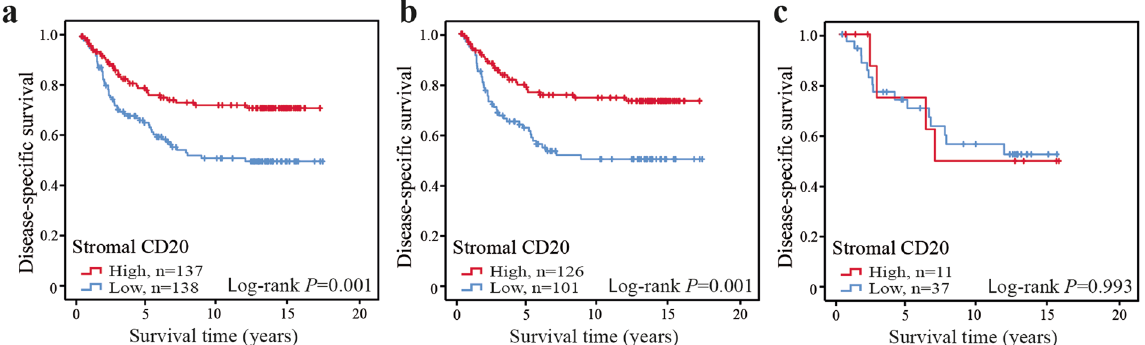
Figure 2. Disease-specific survival in CRC according to infiltration of CD20 + cells. High or low infiltration of stromal CD20 in CRC cases ( a ), in non-irradiated CRC cases ( b ), and in irradiated rectal cancers ( c ). Shown are Kaplan-Meier plots. Log-rank tests were used to calculate P -values.